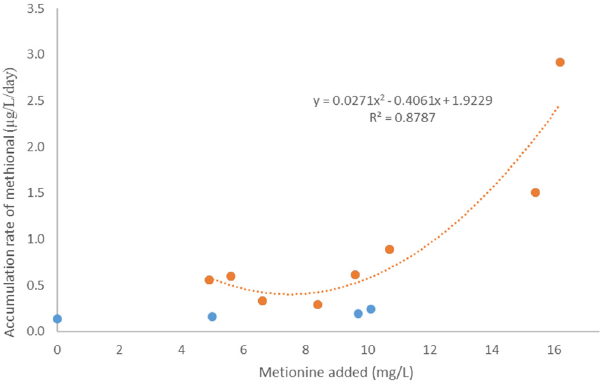
Figure 4. Correlation between methional accumulation rate ( µ g/L/day) and concentration of added methionine (mg/L). Blue dots correspond to white and rosé wines. The 8 reds are represented in orange.